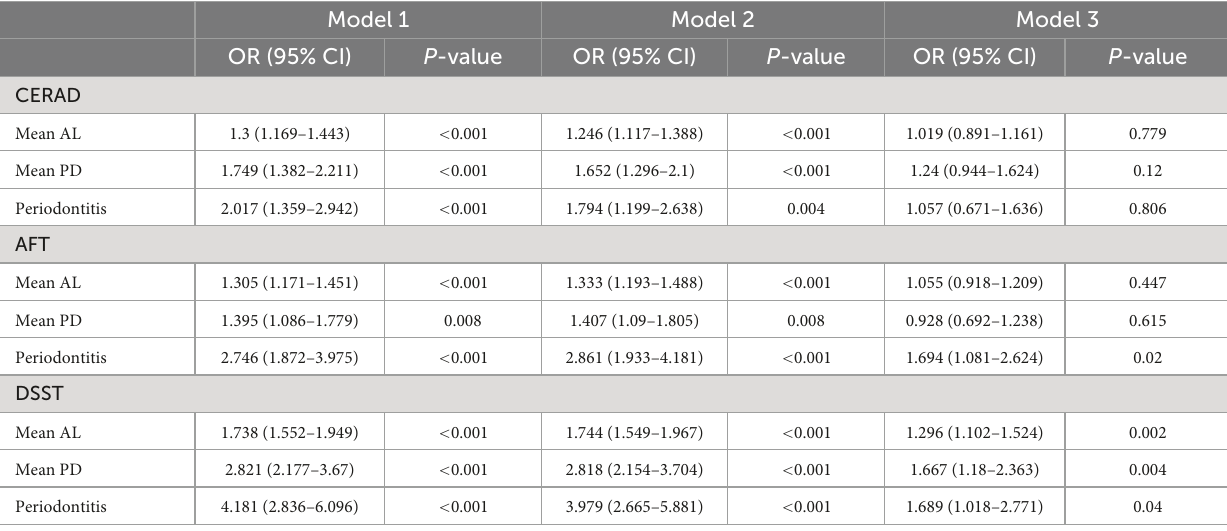
Table 8 . After adjusting for all confounding factors, the